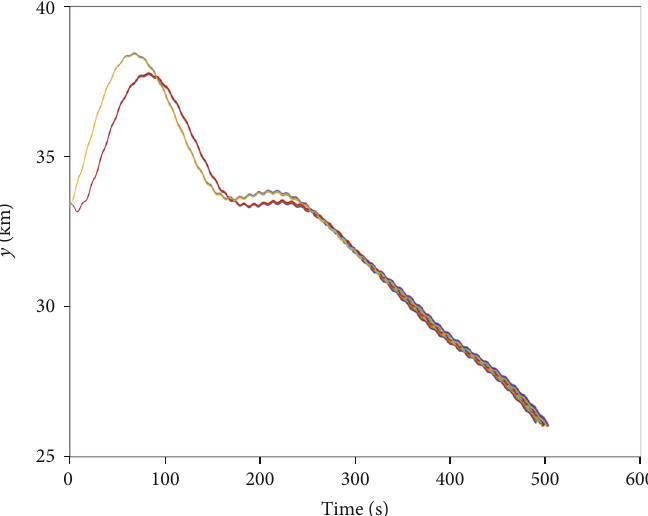
Figure 28: Altitudes in the Monte Carlo simulations.